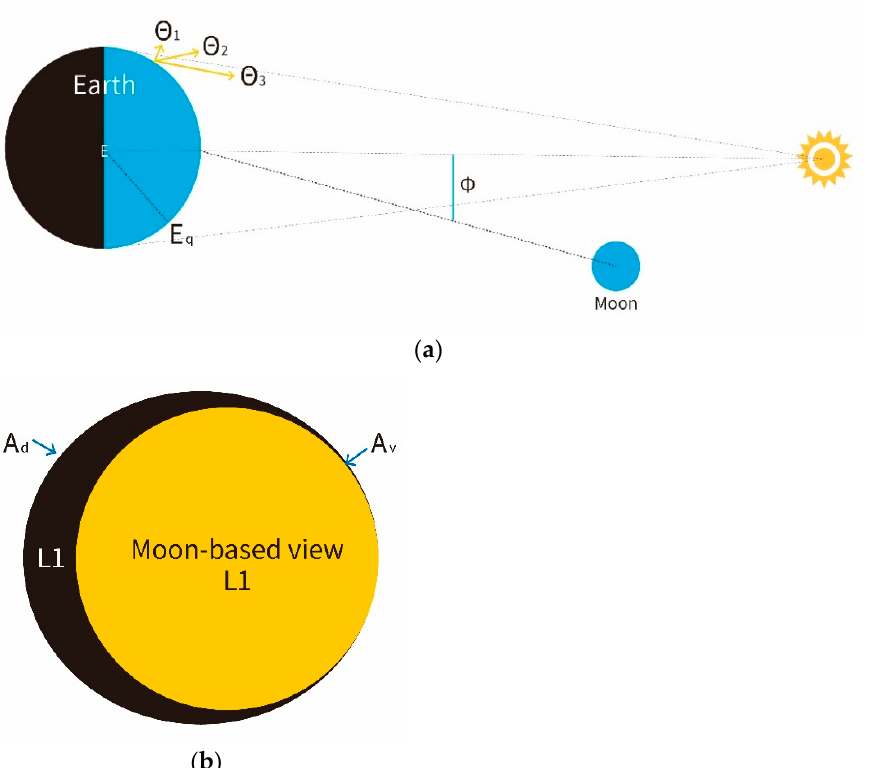
Figure 1. The schematic of the Earth–Sun–Moon geometry ( a , b ) Earth disc visible to the Moon-based view. The schematic was adapted from [12]. Θ 1, Θ 2, and Θ 3 indicate the varied reflectance of a region on Earth surface; Φ is the relative azimuth angle between the solar plane and Moon; E is the center of Earth and Eq is the radius of Earth. L1 is the Earth disc in the Moon-based view; A d is the fractional area of shadow Earth (nighttime, with black color); A v is the fractional area of sunlit Earth (daytime, with yellow color).